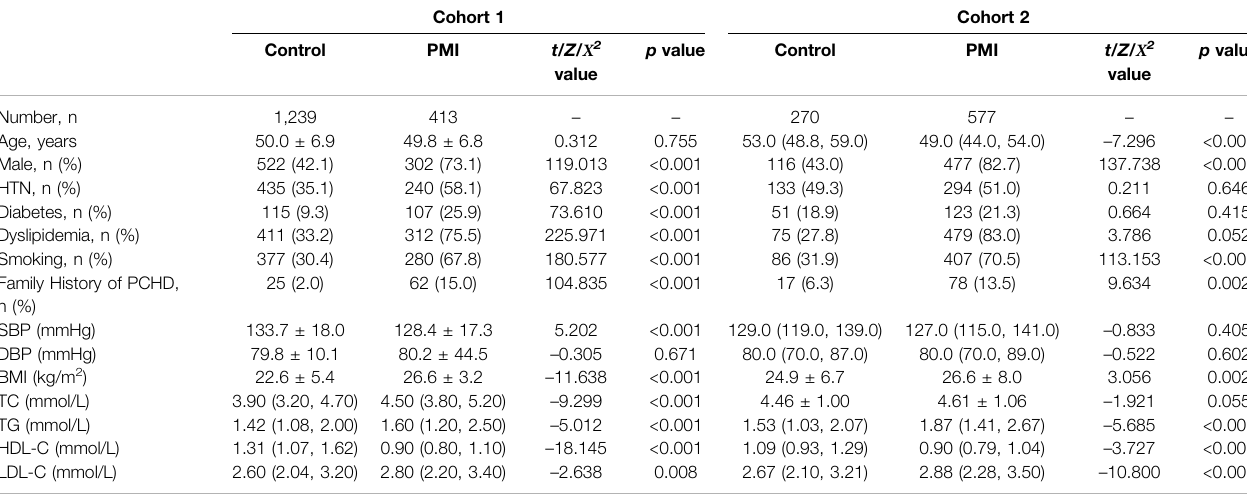
TABLE 1 | Demographics and baseline characteristics of the two cohorts in this